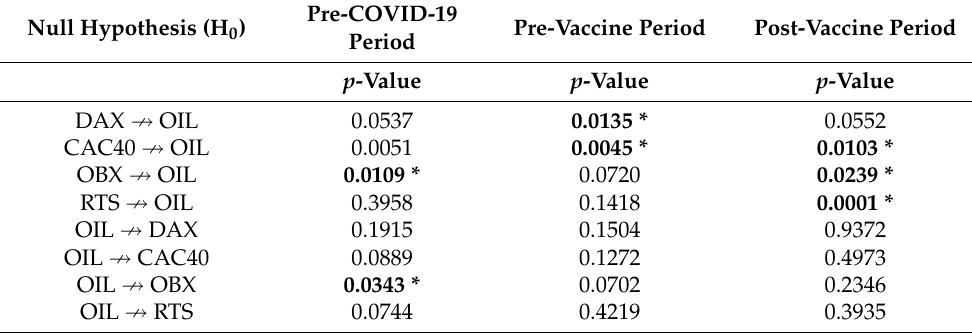
Table 3. Granger Causality Test.